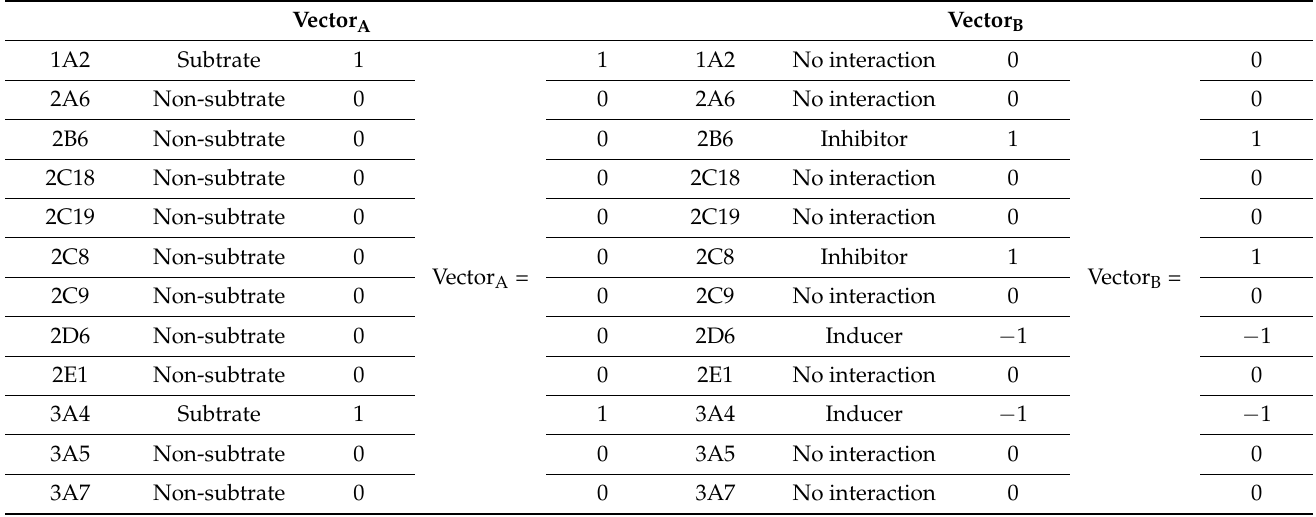
Table 1. Description of the feature extraction from CYP450 groups.